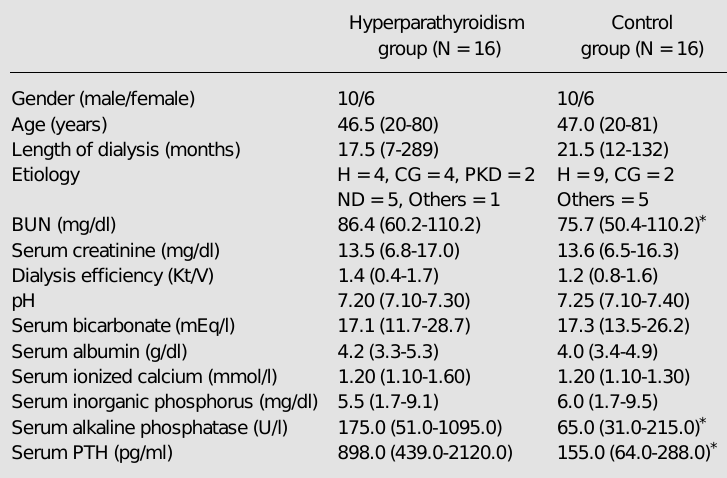
Table 1 - Clinical and biochemical characterization of the patients. Data are reported as median and range (in parentheses). H = Hypertension, CG = chronic glomerulonephritis, PKD = polycystic kidney disease, BUN = blood urea nitrogen, PTH = parathyroid hormone, ND = not determined. * P<0.05 vs control group (Mann-Whitney